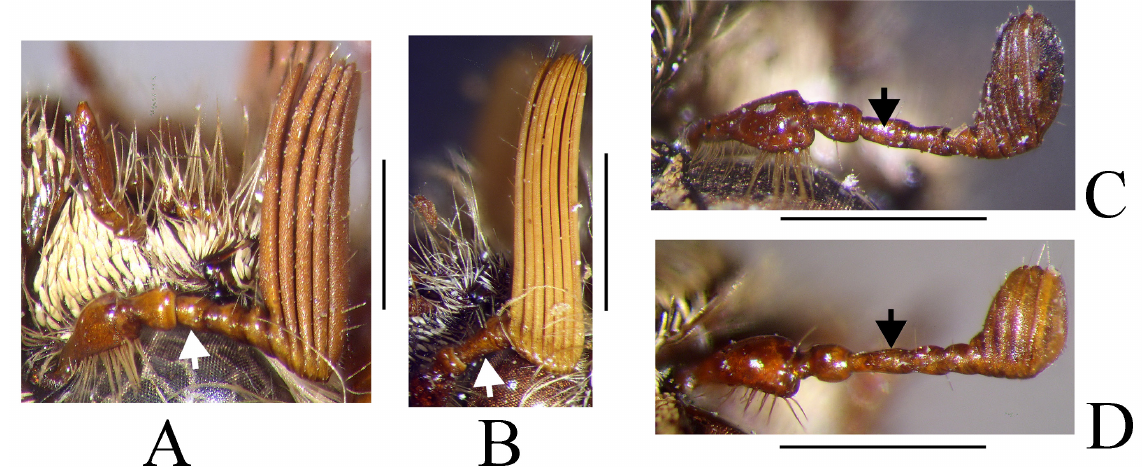
Fig. 6. Shape of 3 rd antennomere (arrowed) in males (A–B) and females (C–D) of the type species of the genera Engertia Dalla Torre, 1913 and Philacelota Heller, 1900. A , C . Engertia amboinae (Brenske, 1897). B , D . Philacelota submaculata Heller, 1900. Scale bars =